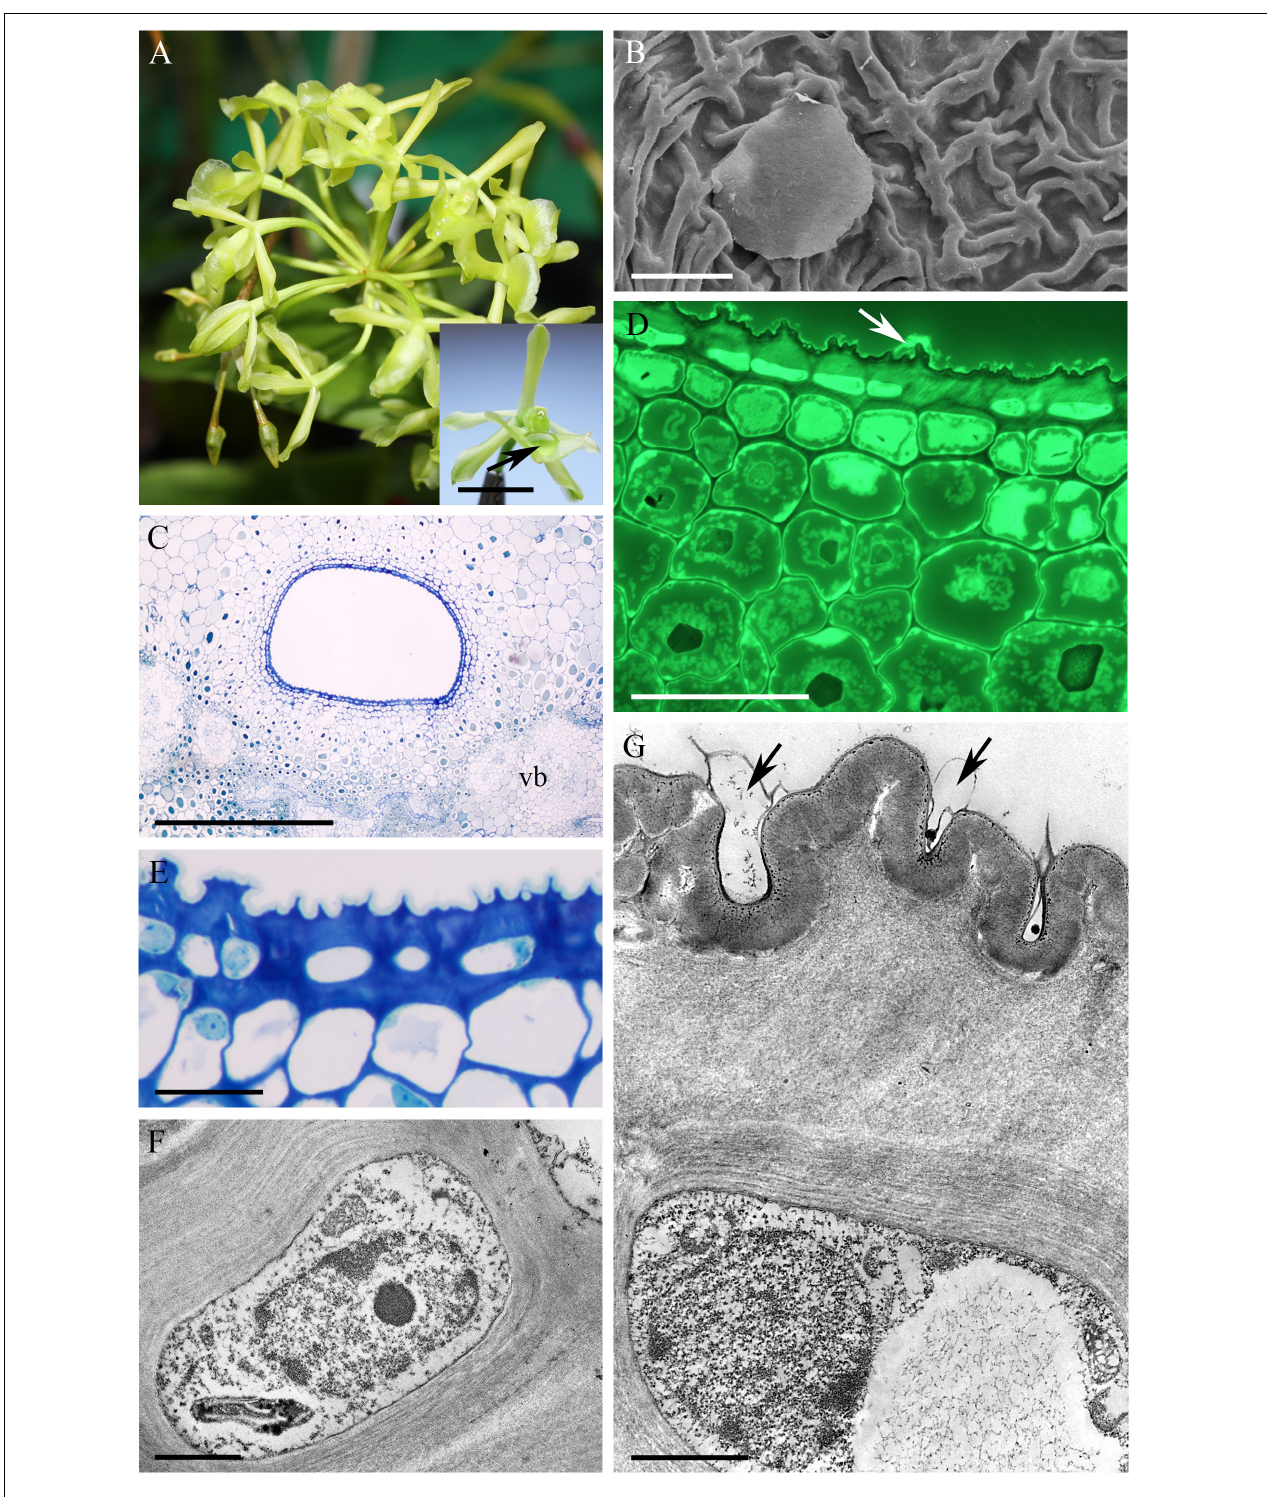
FIGURE 1 | Epidendrum difforme . (A) Inflorescence. Insert shows flower with droplet of nectar (arrow). (B) Convoluted cuticle on surface of epidermal cells with nectar residue. (C) Transverse section through cuniculus showing small epidermal cells enclosing the lumen, and parenchyma cells with intravacuolar phenolic-like contents (MB/AII). (D) Residues of nectar (arrow) on surface of cuticle. Note thick epidermal cell walls and intravacuolar material (auramine O). (E) Detail of epidermis and subepidermal parenchyma (MB/AII). (F) Protoplast of epidermal cell. Note the large nucleus and starchless plastid. (G) Detail of cell wall and cuticle with associated surface secretion (arrows) of epidermal cells lining the cuniculus. Scale bars: A = 1 cm; B,E = 20 µ m; C = 500 µ m; D = 50 µ m; F,G = 2 µ m.